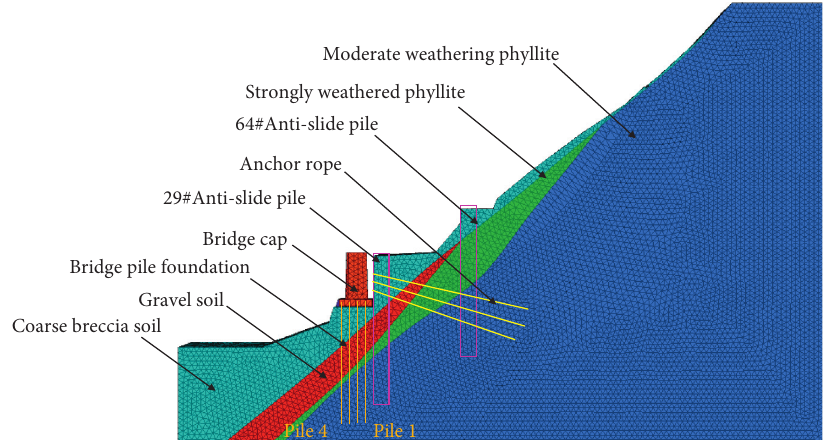
Figure 12: Numerical calculation